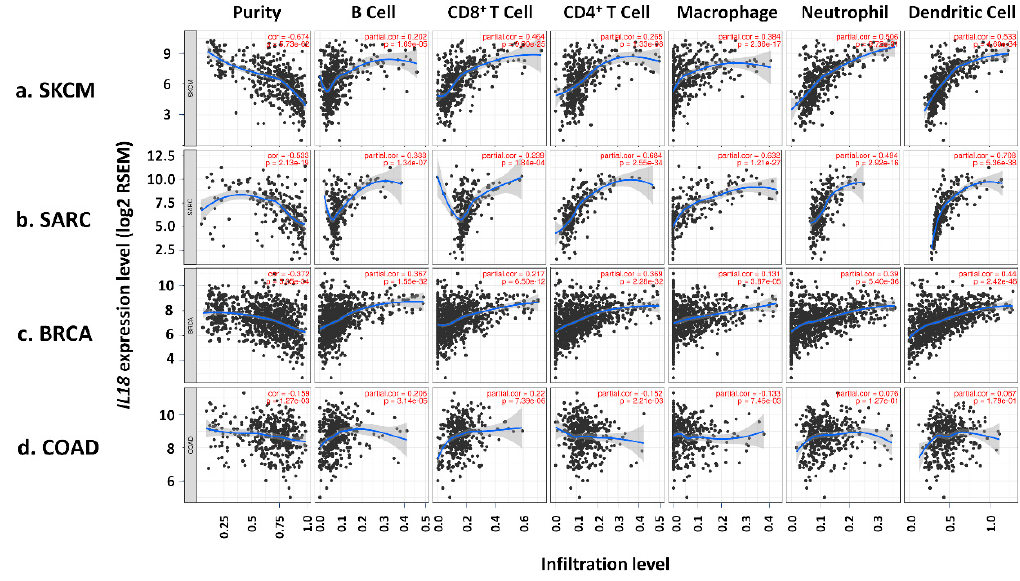
Figure 4. Correlation of IL18 expression with immune infiltration in SKCM, SARC, BRCA, and COAD. A correlation between IL18 expression and the abundance of infiltrating immune cells in the TCGA datasets was investigated with the Tumor Immune Estimation Resource (TIMER) web tool [42] ( a ) IL18 expression is significantly negatively correlated with tumor purity and positively correlated with levels of various infiltrating immune cells including B cells, CD8 + T cells, CD4 + T cells, macrophages, neutrophils, and dendritic cells. Similar to SKCM, IL18 expression and immune infiltration were positively correlated in ( b ) SARC and ( c ) BRCA. ( d ) IL18 expression was not significantly correlated with tumor purity and infiltrating levels of immune cells in COAD. Correlation constants and P -values are listed in Supplementary Table S5.